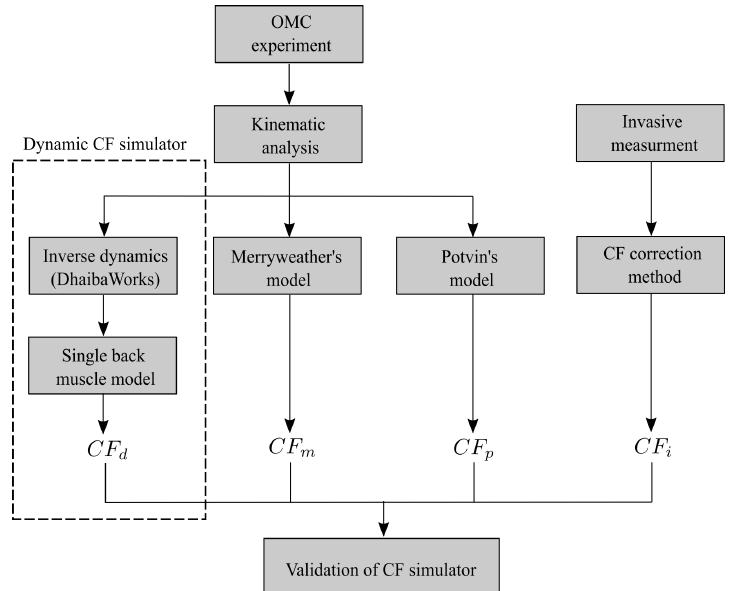
Figure 3. Flowchart of compressive force (CF) estimation procedure and validation of the CF simulator. Each motion was recorded by a motion-capture system, and kinematics data were used for estimating the CF in the CF simulator and in the models by Potvin and Merryweather [15,16]. The data were compared with invasive experimental data to evaluate the precision of each